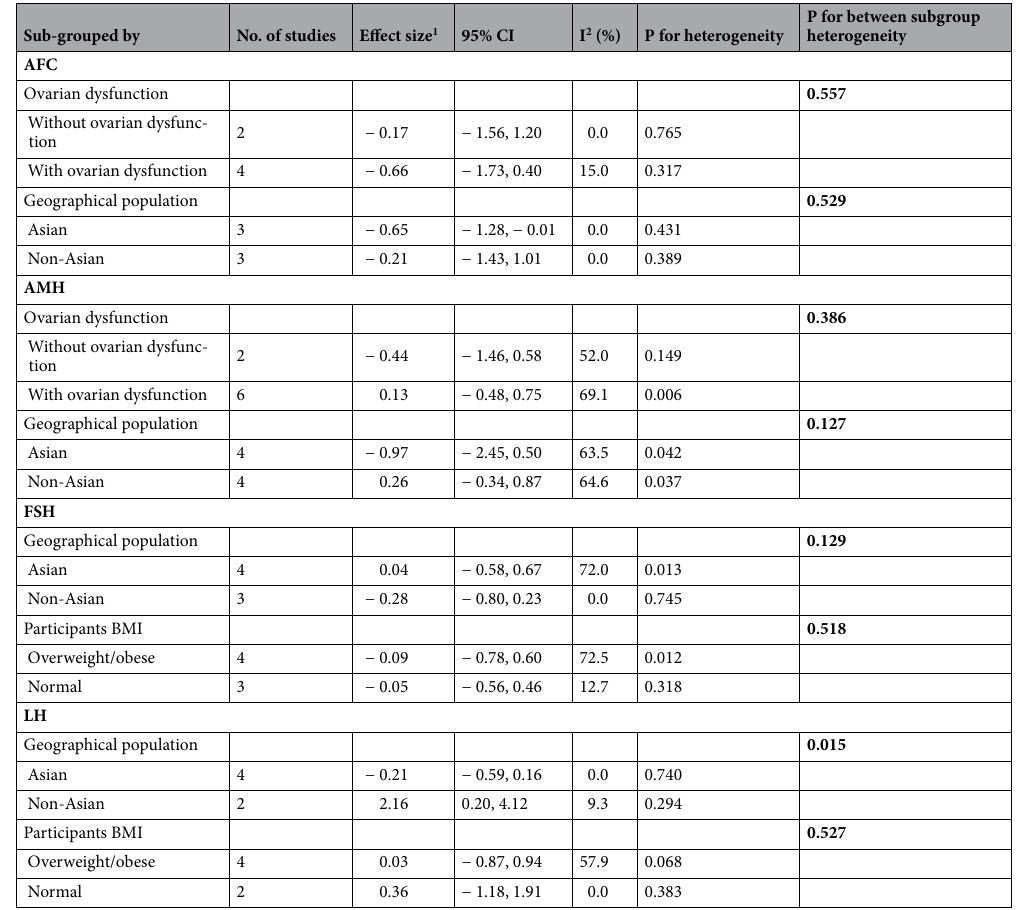
Table 2. Subgroup analysis of the differences in ovarian reserve markers between women with vitamin D insufficiency/deficiency and controls. AFC antral follicle count, AMH anti-Mullerian hormone, FSH follicle stimulating hormone, LH luteinizing hormone, BMI body mass index. 1 Calculated by Random-effects model as weighted mean